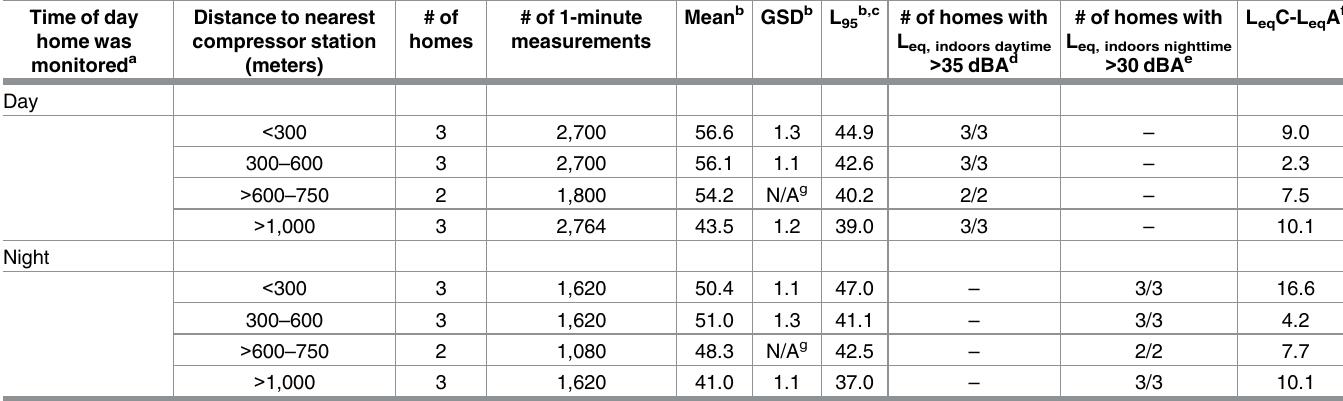
Table 2. Summarystatistics for A-weighted indoor noise levels (dBA) stratified by distance and time of day. Time of day home was monitored